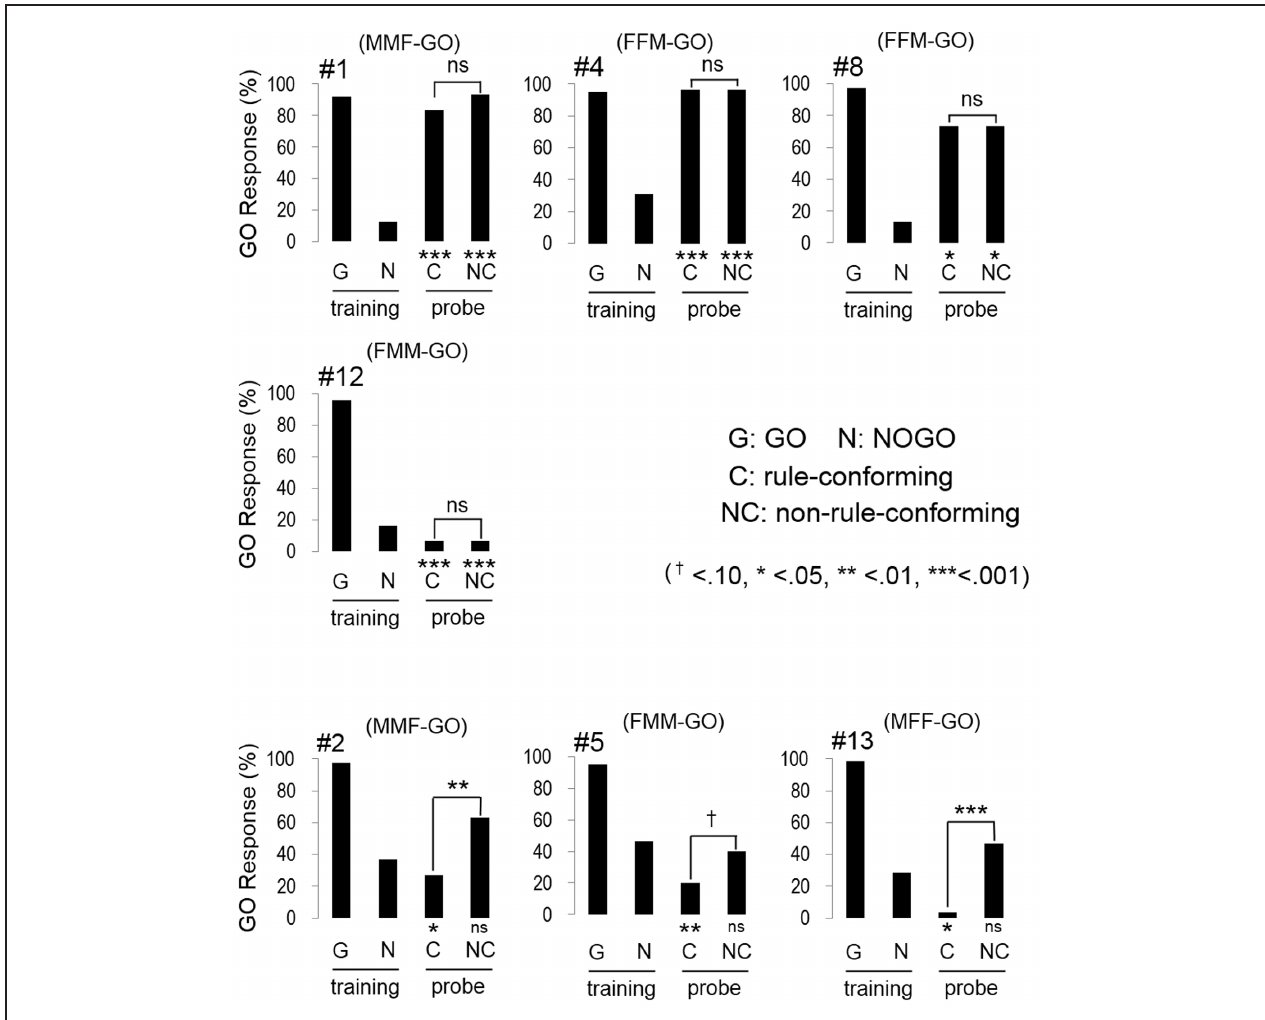
FIGURE 2 | Response of the birds in the test sessions. Three birds (#1, #4, #8) had a strong bias to GO direction for every sound stimulus except NOGO stimulus, although #12 had a strong bias to NOGO direction for every sound